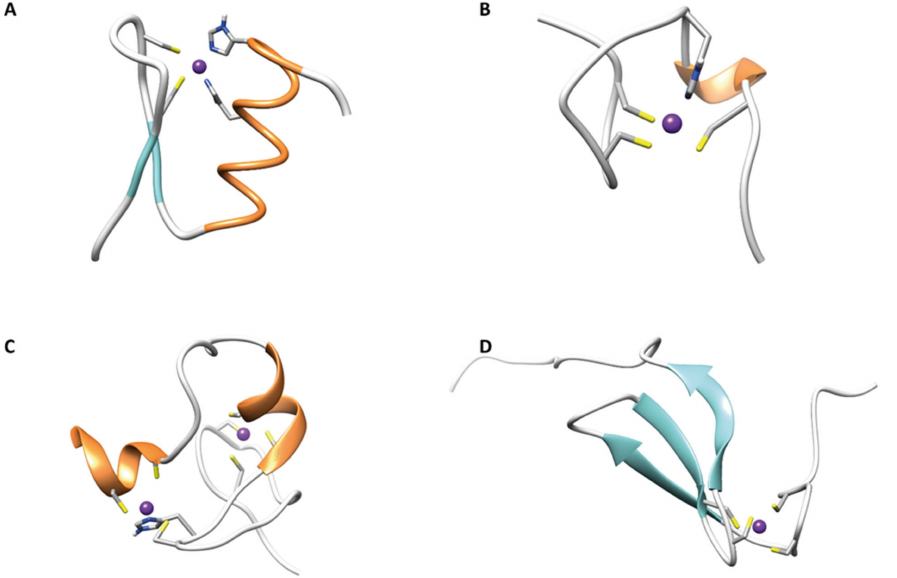
Figure 2. ( A ) First ZNF of TFIIIA ( ββα zinc finger) (PDB code 1TF3); ( B ) C-terminal ZNF of HIVNCp7 (gag knuckle) (PDB code 2L44); ( C ) C-terminal ZNF of RING finger protein 141 (treble clef finger) (PDB code 5XEK); ( D ) N-terminal ZNF of TFIIB (zinc ribbon) (PDB code